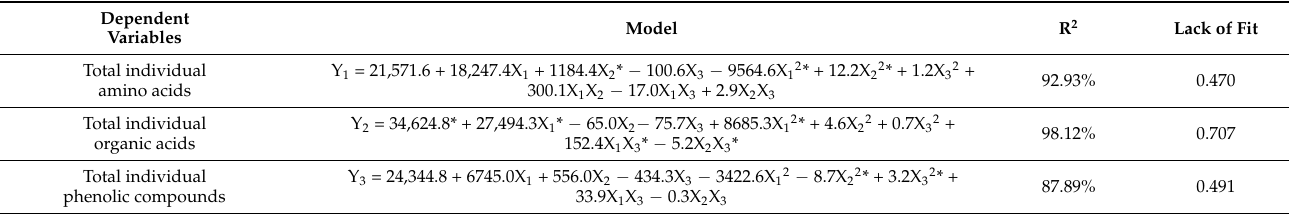
Table 3. Regression equations for bee pollen extracts.